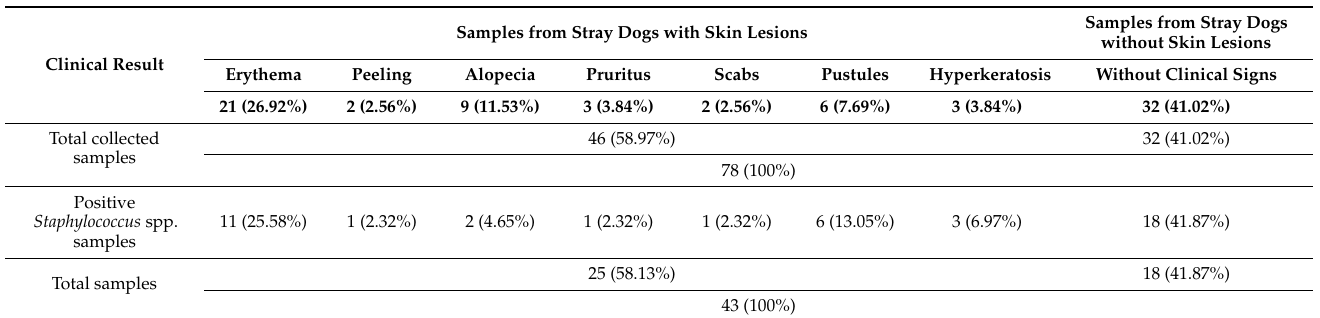
Table 3. Distribution of skin samples that were positive for Staphylococcus spp., according to clinical aspects.